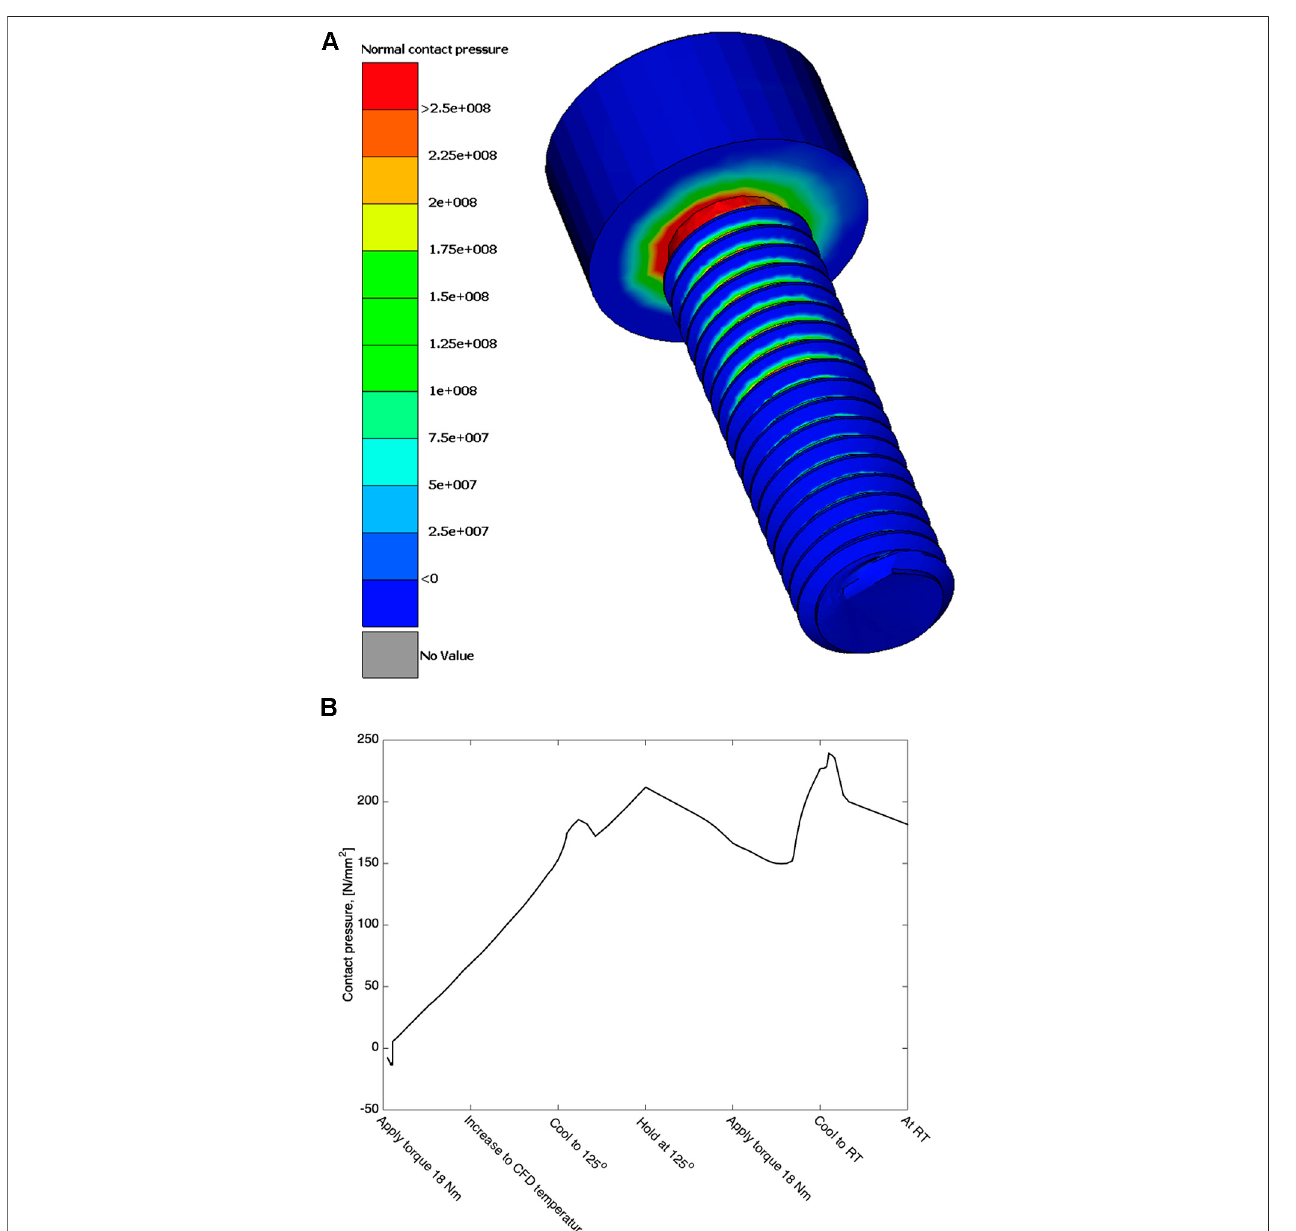
FIGURE 5| Contact pressure at the matingsurface ofthe screw: (A) the distribution ofpressure on the screw head at theend ofthe assembly, (B) the evolution of the average contact pressure on the contact surface.